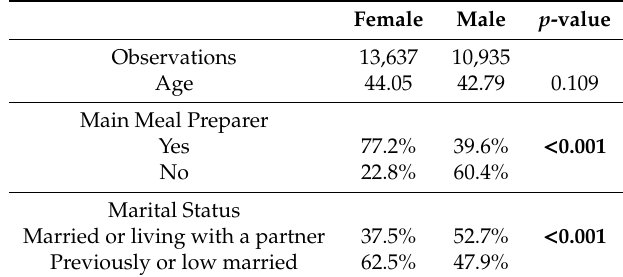
Table 6. Gender di ff erences in meal preparer status and marital status among Non-Hispanic Black adults, ≥ 19 years of age NHANES 2007–2010. (main meal planner / preparer weighted population =